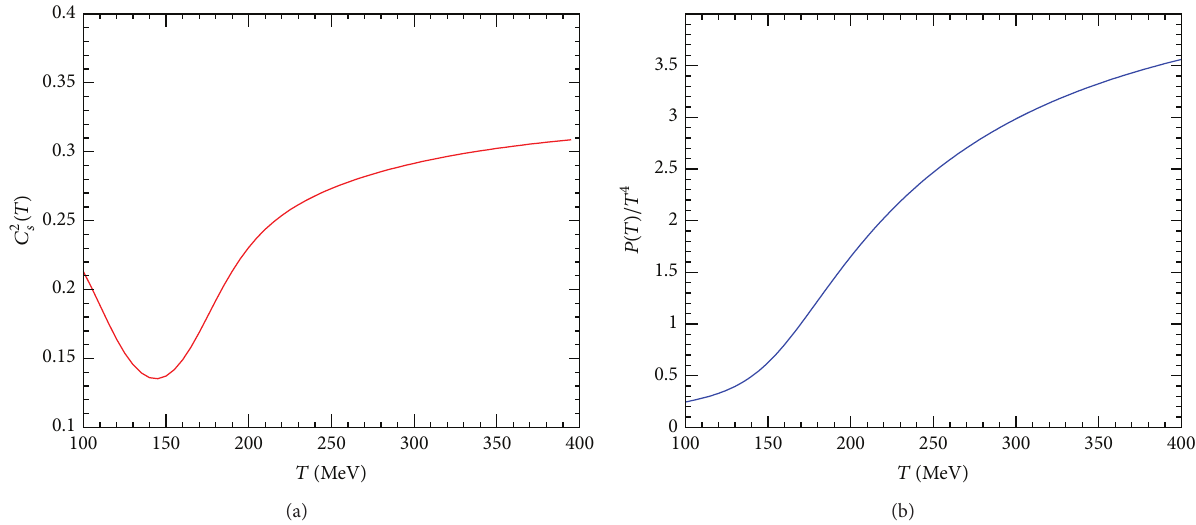
Figure 3: (a) The squared velocity of sound varies as a function of temperature 𝑇 and (b) the pressure varies as a function of temperature 𝑇 (color online).